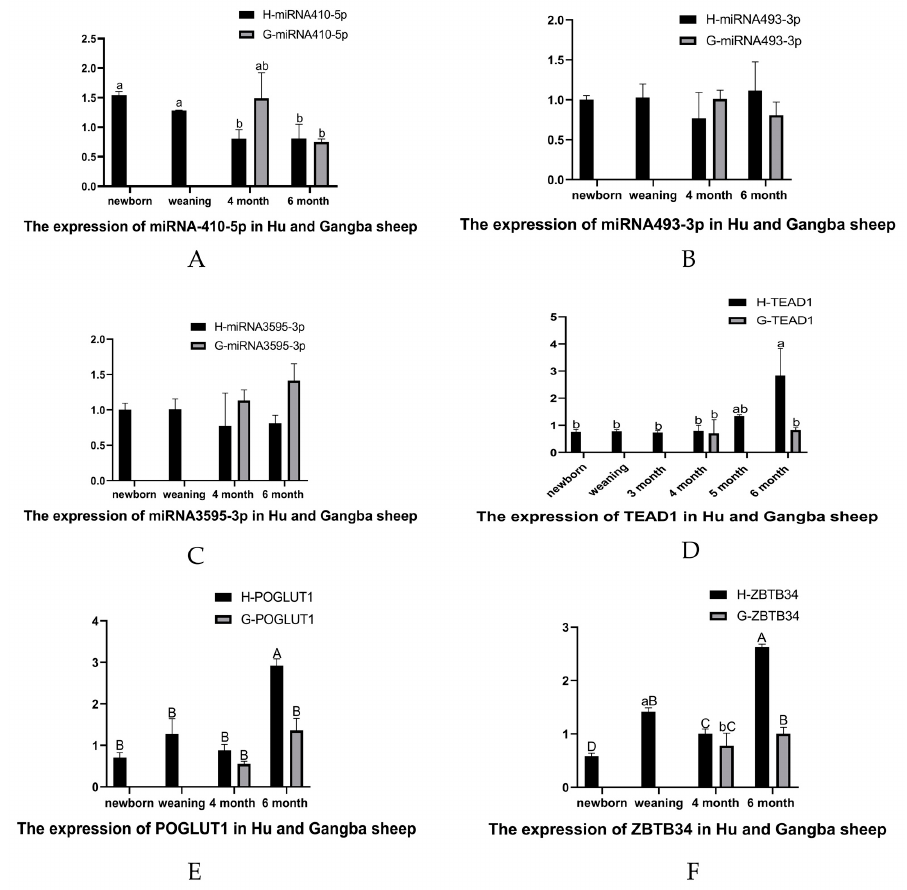
Figure 4. qRT-PCR of DE-miRNAs and target genes in muscle tissues of Hu sheep and Gangba sheep: qRT-PCR results of ( A ) miR-410-5p, ( B ) miR-493-3p, ( C ) miR-3959-3p, ( D ) TEAD1 , ( E ) PUGLUT1 , and ( F ) ZBTB34 in the muscle tissue of Hu sheep and Gangba sheep and the results of the comparative analysis of the muscle tissue expression of the two sheep breeds at 4 and 6 months of age. a and b represent significant results, and A, B, C and D represent extremely significant results. 3.8. Knocked-Down TEAD1 Expression Inhibited the Proliferation of Sheep Primary Embryonic Myoblasts Three pairs of TEAD1 siRNAs were constructed and transfected into sheep primary embryonic myoblasts, and it was found that the knockdown efficiency of siRNA1 was better, which could reduce the expression of TEAD1 gene to approximately 40% of the original, and had a lower miss efficiency (Figure 5A). Moreover, we found that the num- ber of myoblasts in the TEAD1 knockdown group was significantly less than that in the siNC group and control group (Figure 5A).